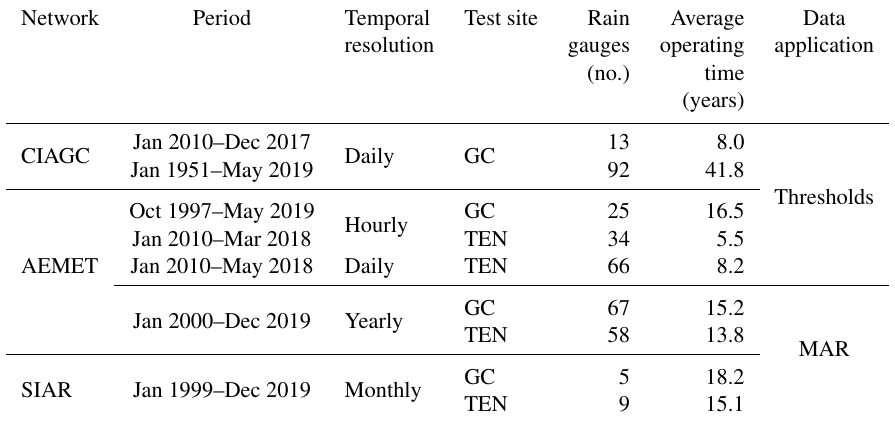
Table 1. Summary of the three available rain gauge networks (CIAGC, AEMET, SIAR) at the two test sites (GC and TEN), i.e., network name, network operating time period, temporal resolution, test site, number of rain gauges used, their average operating time, and the use of data. Network Period Temporal